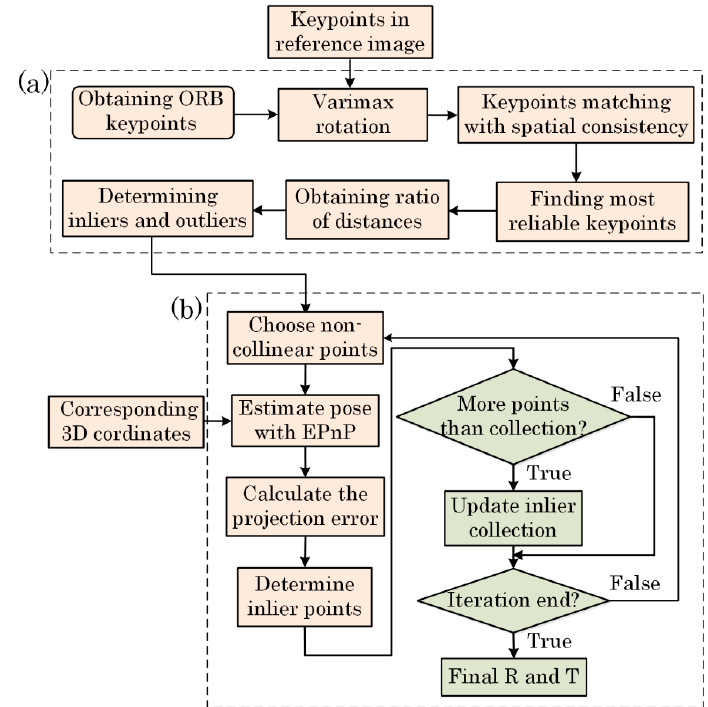
Figure 7. Flow chart of improved RANSAC method ( a ) Preprocess step of RANSAC to reject some outliers and improve the inliers percentage. ( b ) Ordinary RANSAC algorithm.